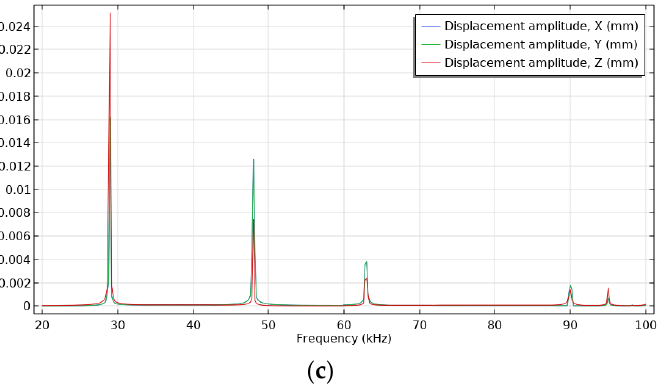
Figure 4. Theoretical amplitude–frequency characteristics of piezoelectric transducers using Comsol multiphysics: ( a ) with flat surface; ( b ) with ring-shaped surface with 59 mm outer diameter; ( c ) with ring-shaped surface with 100 mm outer diameter.